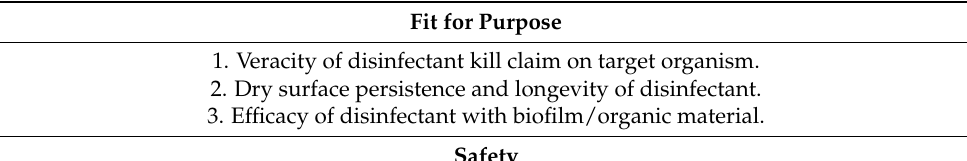
Table 2. Proposed framework for ideal disinfection as part of a larger infection prevention and control